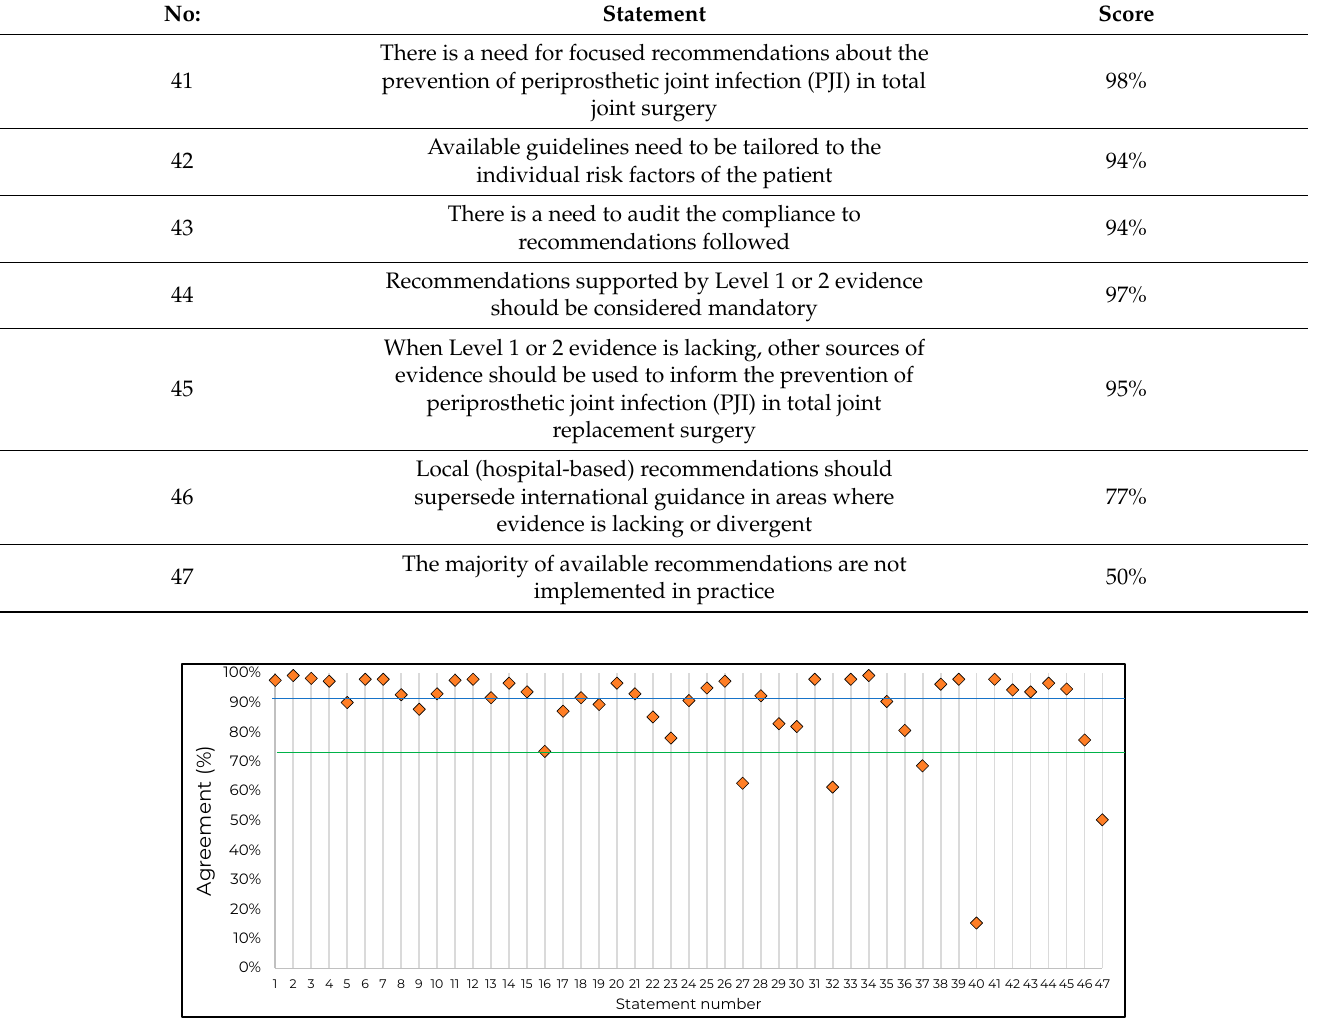
Figure 1. Consensus agreement by statement. Horizontal lines represent the thresholds for very high consensus (at 90%, in blue) and consensus (at 75%, in green). Orange diamonds represent the percentage of agreement per statement.